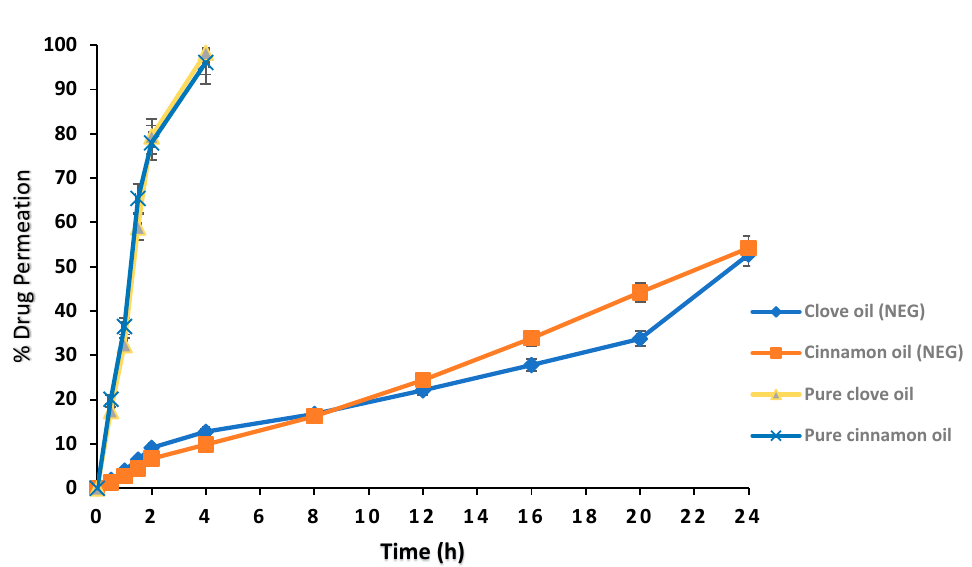
Figure 6. Goat buccal mucosal permeation of the essential oil from optimized nanoemulgel formulation.